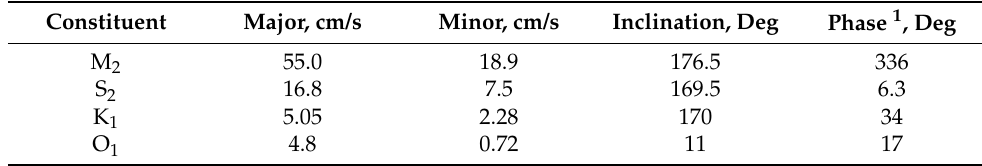
Table 1. Ellipse properties of the major semidiurnal and diurnal barotropic tidal constituents at the mooring